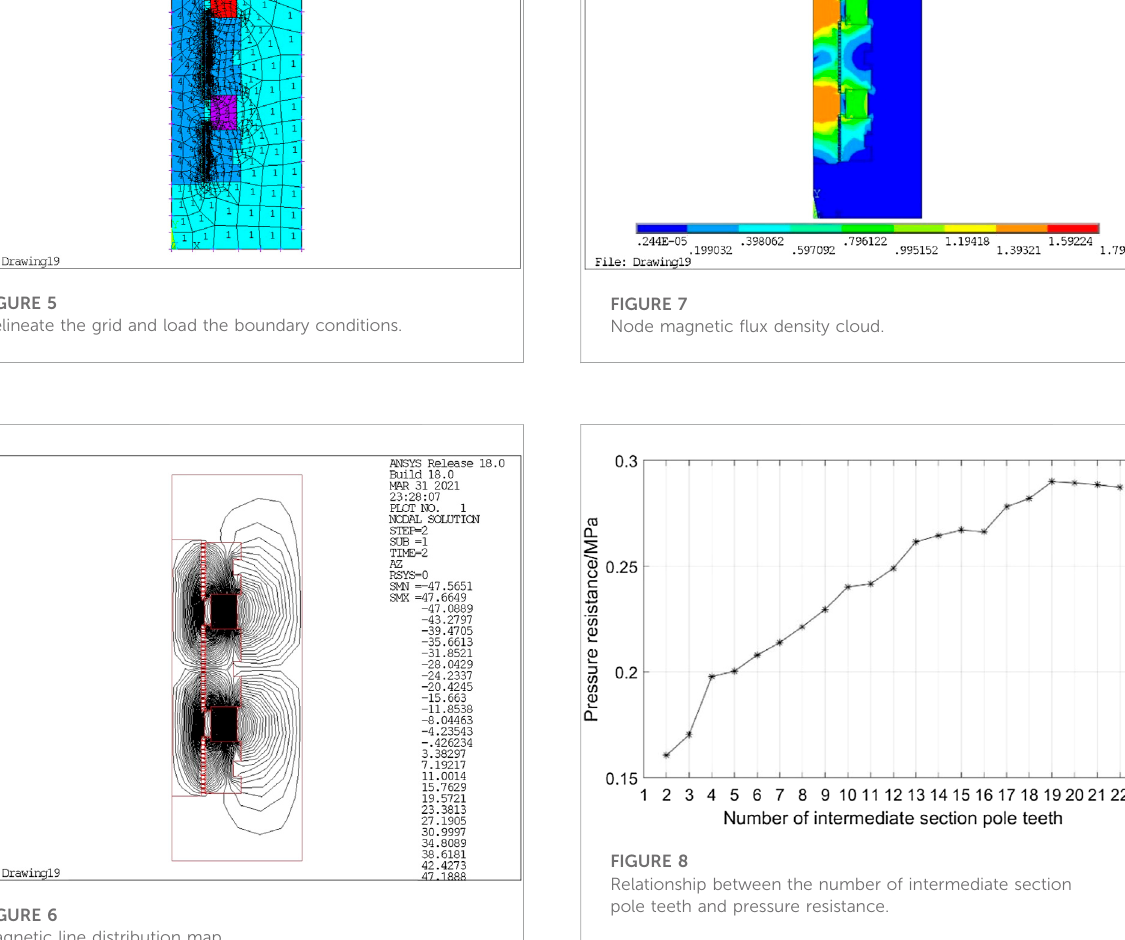
FIGURE 8 Relationship between the number of intermediate section pole teeth and pressure